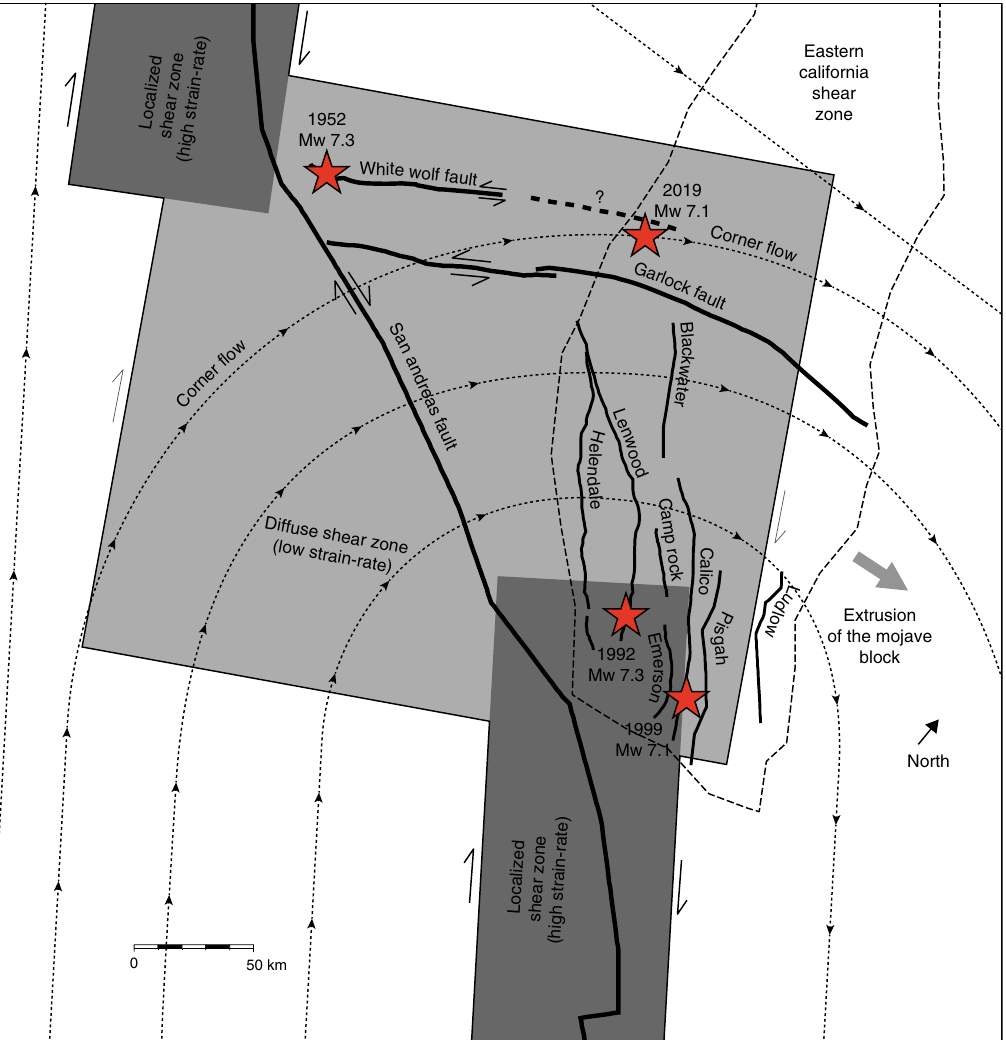
Fig. 7 Evolution of fault activity due to extrusion of the Mojave block. Deformation in the Mojave is associated with corner fl ow distributed over a wide shear zone that accommodates the restraining step-over between more localized shear zones below the Carrizo and Coachella sections of the San Andreas fault. Faults that escaped out of the shear zone, like the Ludlow fault, become inactive. As the extrusion of the Mojave block continues, the White Wolf fault may materialize the triple junction at the big bend of the San Andreas fault. The stars represent large earthquakes in the last